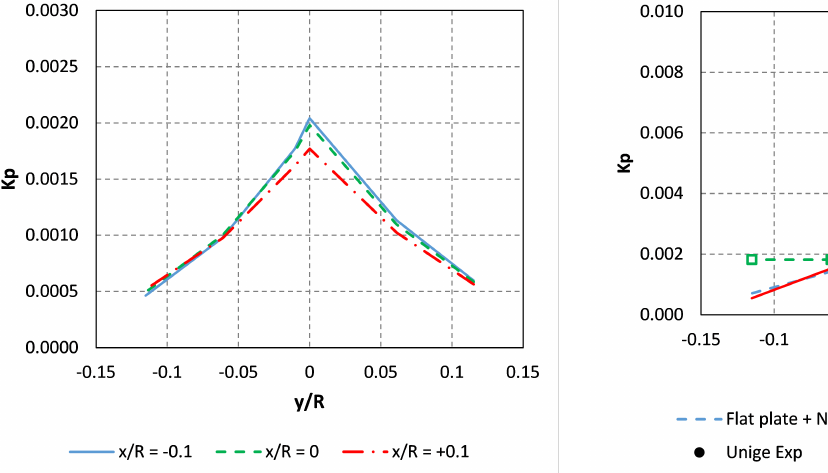
Figure A.8: Comparison between predicted and measured pressure pulses (third harmonic) in cavitating condition on the transversal section in correspondence of the propeller